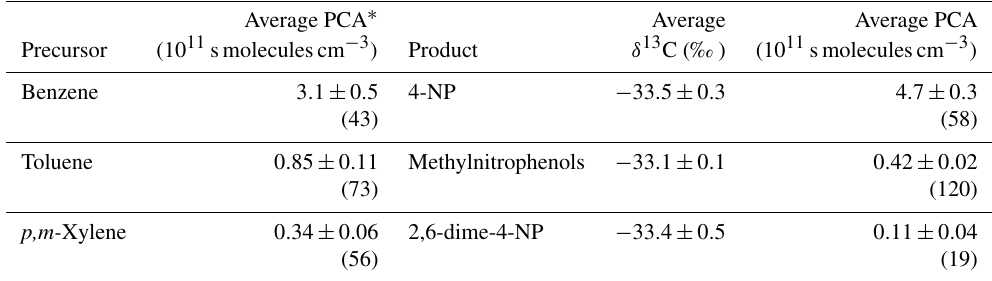
Table 3. Averages and uncertainty of the mean PCA for nitrophenols in both PM and the gas phase in addition to PM calculated for Scenario 3. Also shown are the average carbon isotope ratios. The number of data points used is shown in parentheses. For comparison, the PCA calculated from the carbon isotope ratios of the precursor VOCs reported by Kornilova et al. (2016) for Toronto are